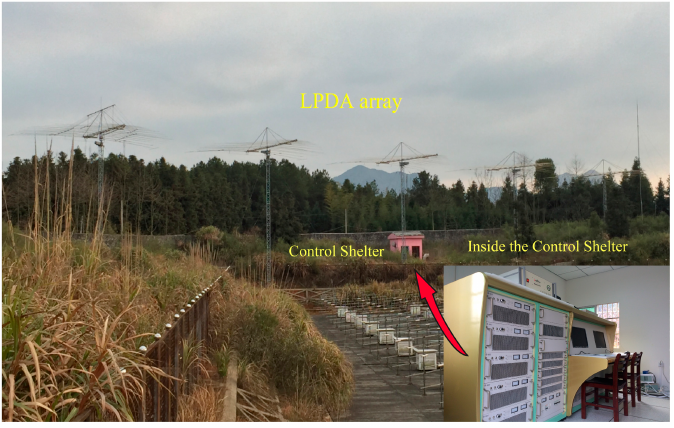
Figure 1. Photo of WIOBSS-AA site showing the log-periodic antenna array. The pink building in the center of the photo is the shelter of the hardware. The mainframe of the WIOBSS-AA is displayed in the lower right corner.